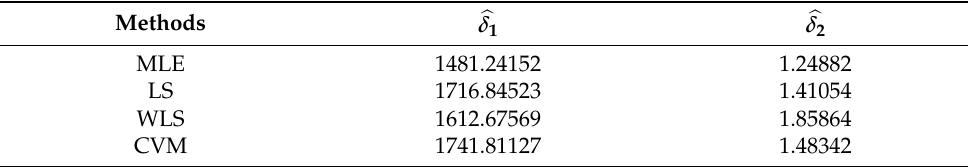
Table 14. The estimations for all estimation methods under the RW